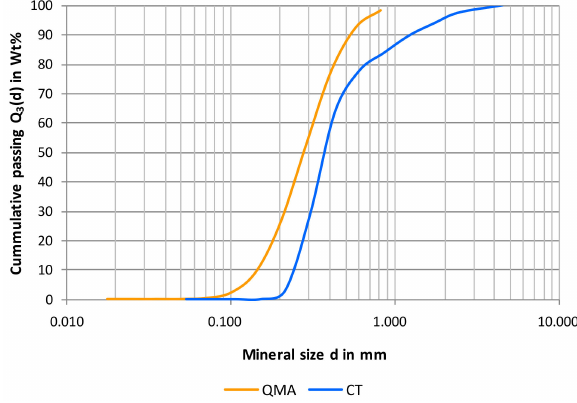
Figure 18. Grain size distributions of copper minerals in copper